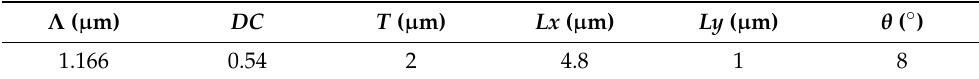
Table 1. The optimized parameters of the Si 3 N 4 strip-loaded grating coupler at a wavelength of 1.55 µ